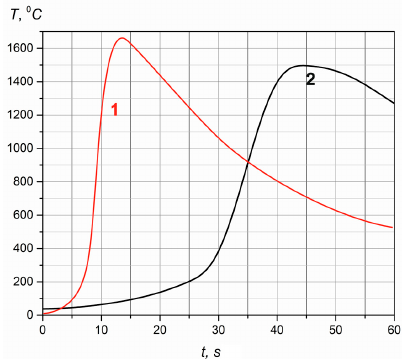
Figure 4. The temperature profiles obtained by combustion of powder (1) and granules (2) of chromium: q = 12 cm 3 /(s·cm 2 ); [N 2 ] = 100 %.